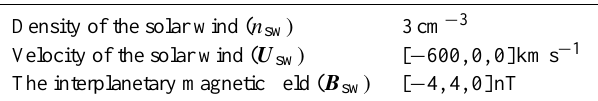
Table 2. Solar wind parameters used in this paper in the hybrid